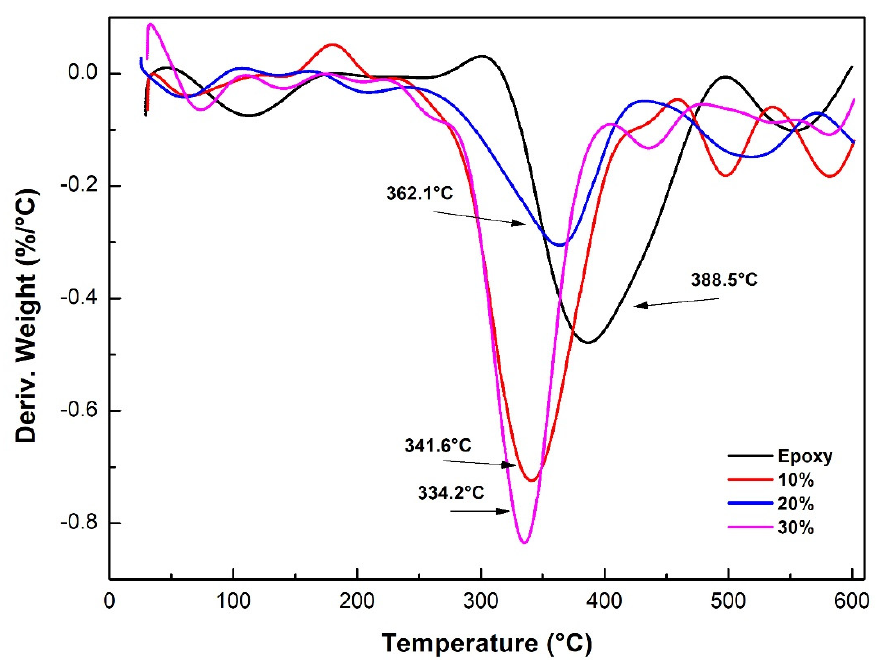
Figure 10. DTG curves for the epoxy resin and for the sedge fiber-reinforced composites.